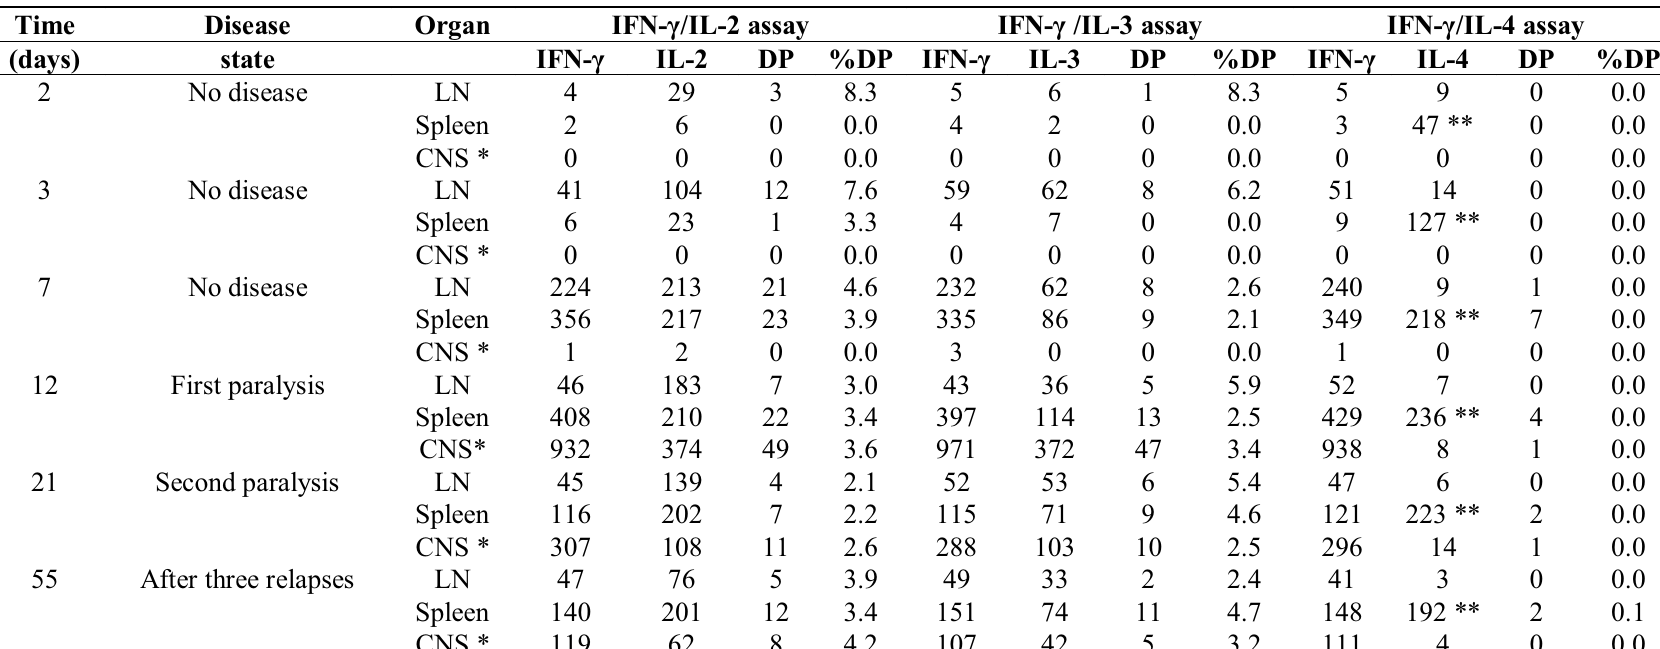
Table 1. PLP:139-151-induced co-expression of IL-2, IL-3, IL-4, and IFN- (cid:534)(cid:3)(cid:76)(cid:81)(cid:3)(cid:73)(cid:85)(cid:72)(cid:86)(cid:75)(cid:79)(cid:92)(cid:3)(cid:76)(cid:86)(cid:82)(cid:79)(cid:68)(cid:87)(cid:72)(cid:71)(cid:3)(cid:80)(cid:72)(cid:80)(cid:82)(cid:85)(cid:92)(cid:3)(cid:38)(cid:39)(cid:23)(cid:3)(cid:55)(cid:3)(cid:70)(cid:72)(cid:79)(cid:79)(cid:86)(cid:17)(cid:3)(cid:54)(cid:45)(cid:47)(cid:3)(cid:80)(cid:76)(cid:70)(cid:72)(cid:3)(cid:90)(cid:72)(cid:85)(cid:72)(cid:3)(cid:76)(cid:80)(cid:80)(cid:88)(cid:81)(cid:76)(cid:93)(cid:72)(cid:71)(cid:3) with PLP:139-151 peptide and at the time points indicated, CD4 cells were isolated from the dLN or the spleen. CD4 cells were tested in serial dilutions starting at 3 × 10 5 cells per well with 5 × 10 5 APC (irradiated naive SJL spleen cells) for the recall response to PLP:139- (cid:20)(cid:24)(cid:20)(cid:3)(cid:11)(cid:21)(cid:19)(cid:3)(cid:541)(cid:48)(cid:12)(cid:3) performing the specified double color cytokine ELISA spot assays. Double color ELISPOT assays were of 48 h duration. Data for individual mice representative of groups of 4 (cid:177) 24 mice tested per time point are shown. The numbers of single-positive and double-positive (DP) cells were measured by image analysis The % DP was calculated as the percentage of double-cytokine-producing cells from the total number of cells producing both cytokines: % DP = DP × 100%/(DP + Cytokine 1 only + Cytokine 2 only). The mean spot numbers of 3 (cid:177) 4 replicate wells are shown for 3 × 10 5 cells per well with SD < 10%. The standard deviation for all % DP calculated was less than % DP ±